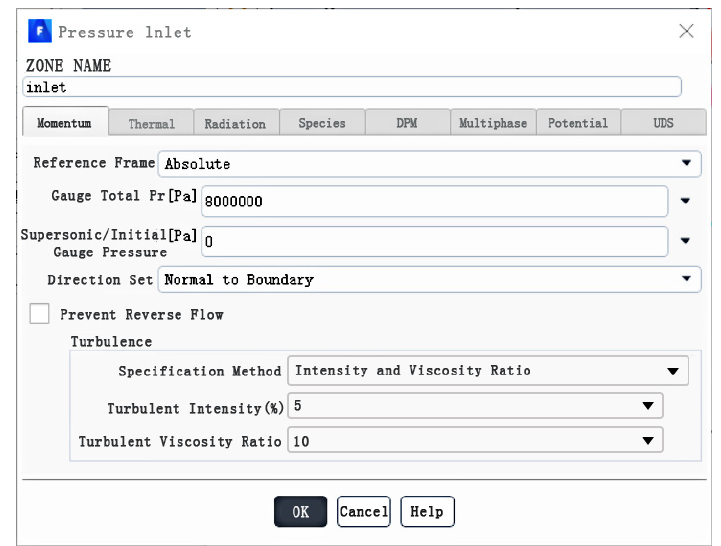
Figure 11. Pressure inlet setting dialog.